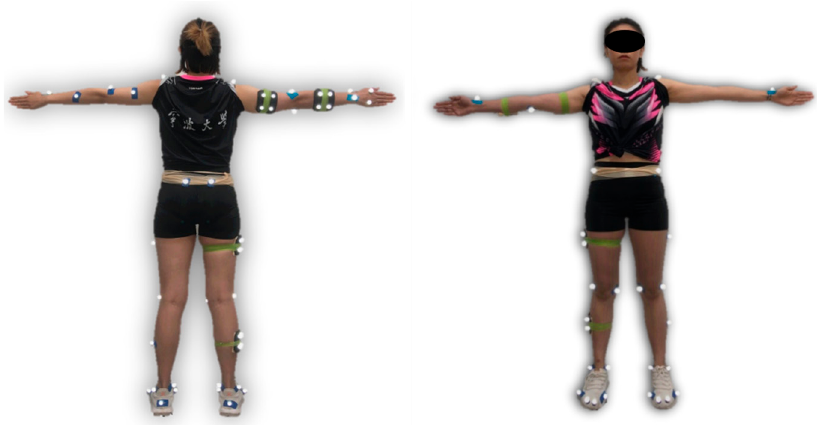
Figure 1. The anatomical locations of markers attached on the table tennis athlete.